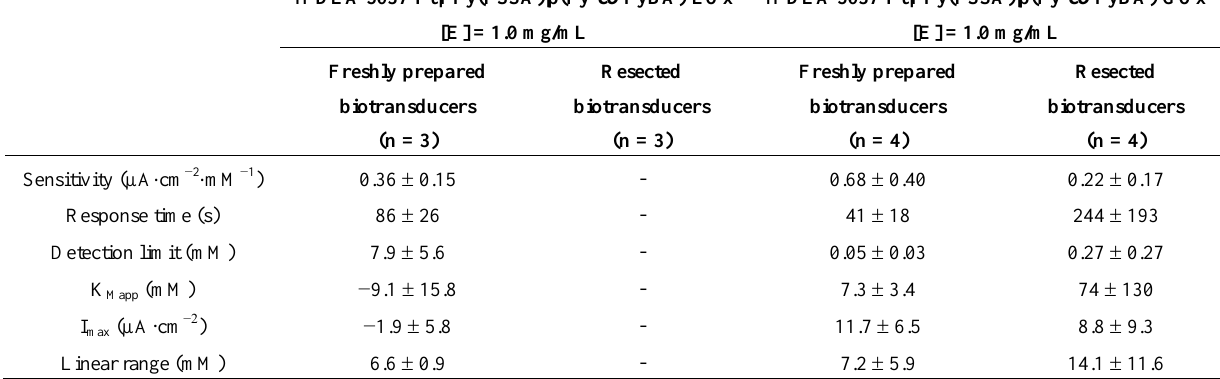
Table 2. Bioanalytical performance parameters for lactate and glucose responsive biotransducers, freshly fabricated and following resection after 3 h of implantation in the trapezius muscle of Sprague-Dawley rats (650 mV bias, PBS, pH = 7.2, 25 °C, ±standard deviation is